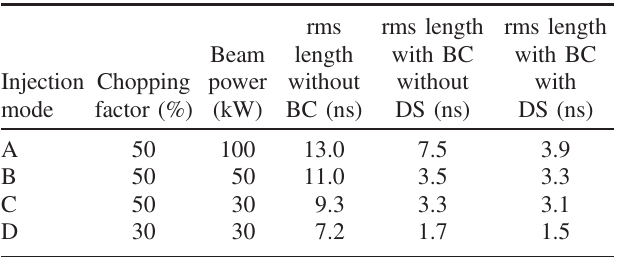
TABLE III. The rms bunch length with different chopping factors and beam